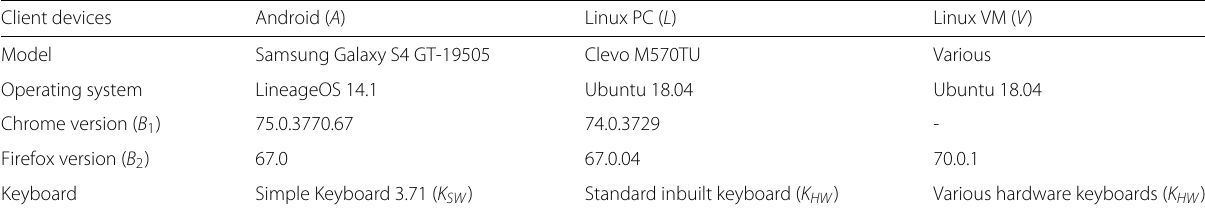
Table 1 Client devices used for data collection: physical devices for both T 1 and T 2 , whereas virtual setup for T 3 Client